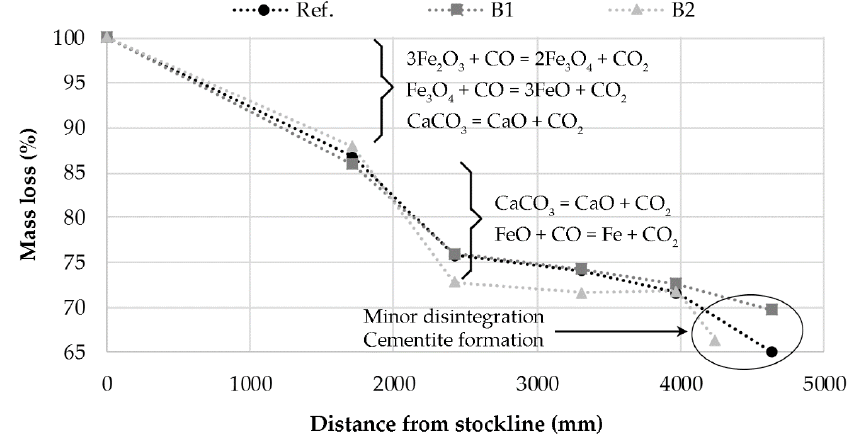
Figure 5. Mass loss and reactions during the descent of the briquettes in the LKAB EBF.